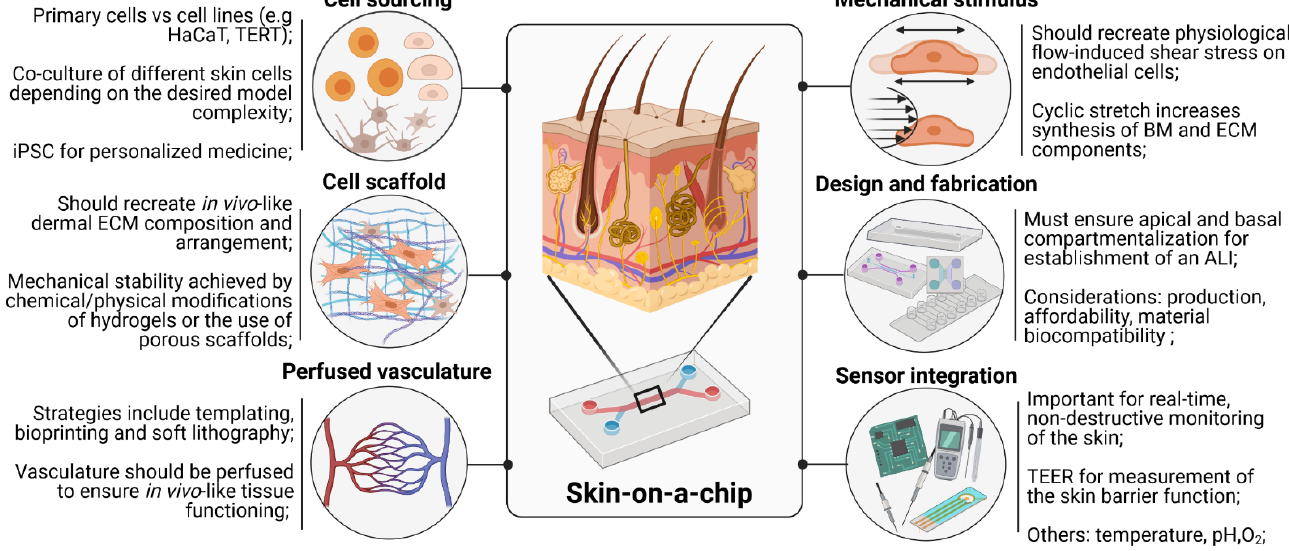
Figure 2. Development of biomimetic skin-on-a-chip platforms. Schematic drawing representing the main factors to be considered when developing physiologically relevant skin-on-a-chip (SoC) models, including technical and biological factors (cell sourcing, cell scaffold, perfusion, cyclic stretching, design and fabrication and sensor integration). The different factors should be evaluated taking into account the specific application as well as available equipment and know-how. ALI: Air-liquid interface; BM: Basement membrane; ECM: Extracellular matrix; TEER: Transepithelial electrical resistance; iPSC: Induced pluripotent stem cells.